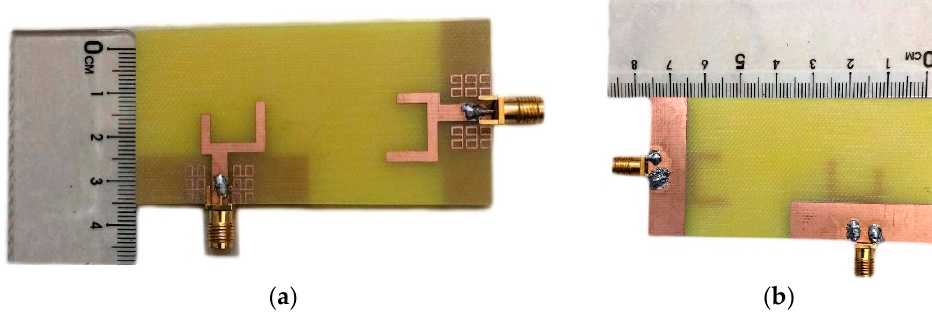
Figure 6. Fabricates antenna; top view ( a ), bottom view ( b ).